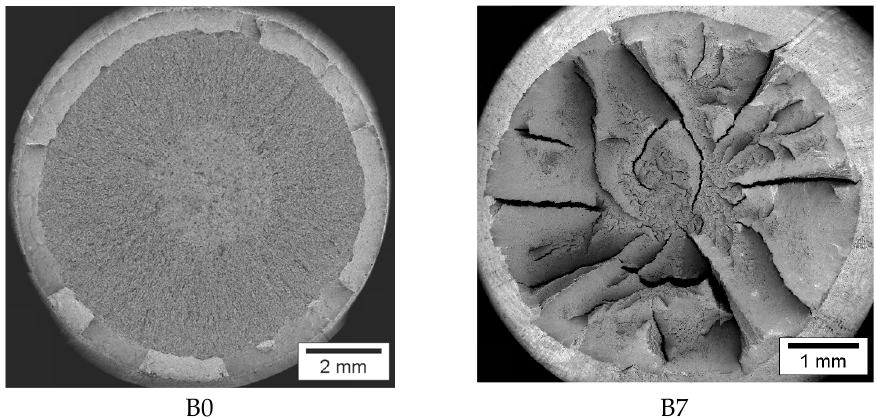
Figure 13. Fracture surfaces in a hot rolled bar ( left ) and a cold drawn wire ( right ).